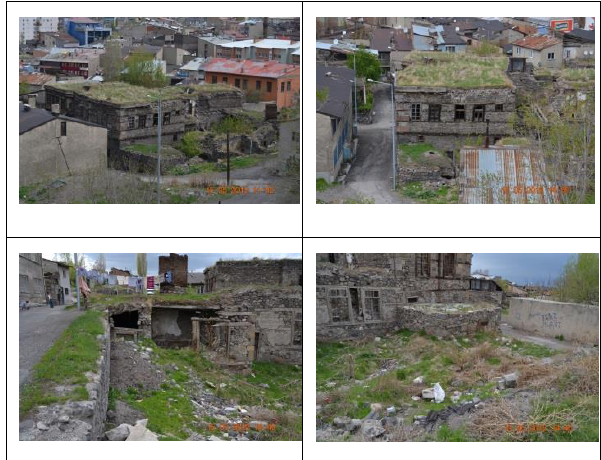
Figure 3. General Condition of the Mansion